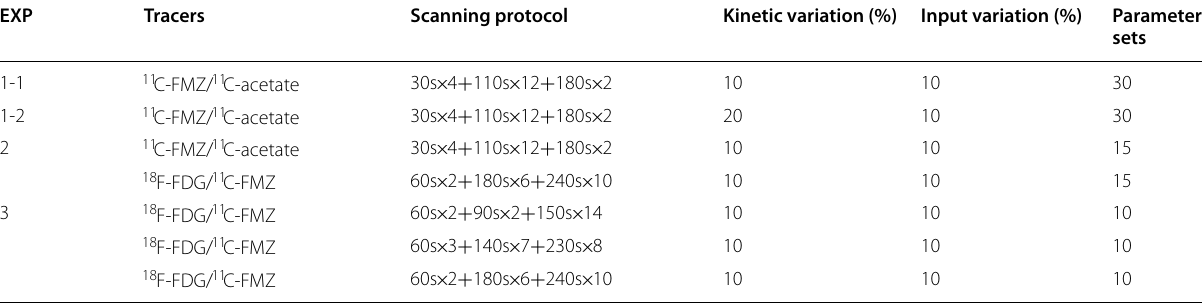
Table 1 Settings of the simulation experiments EXP